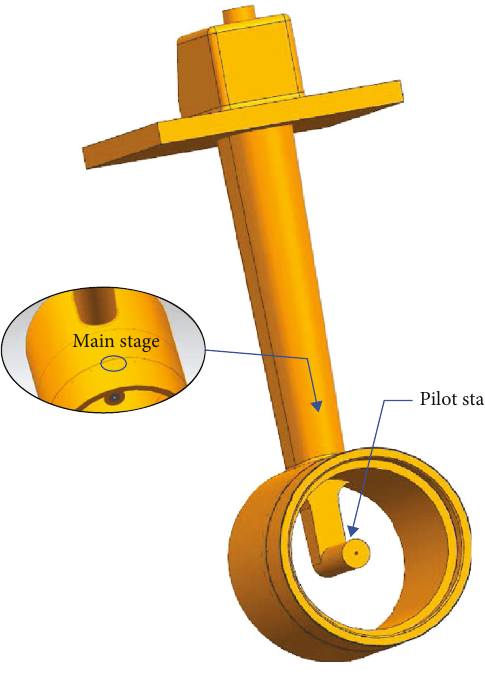
Figure 3: Test injector model.